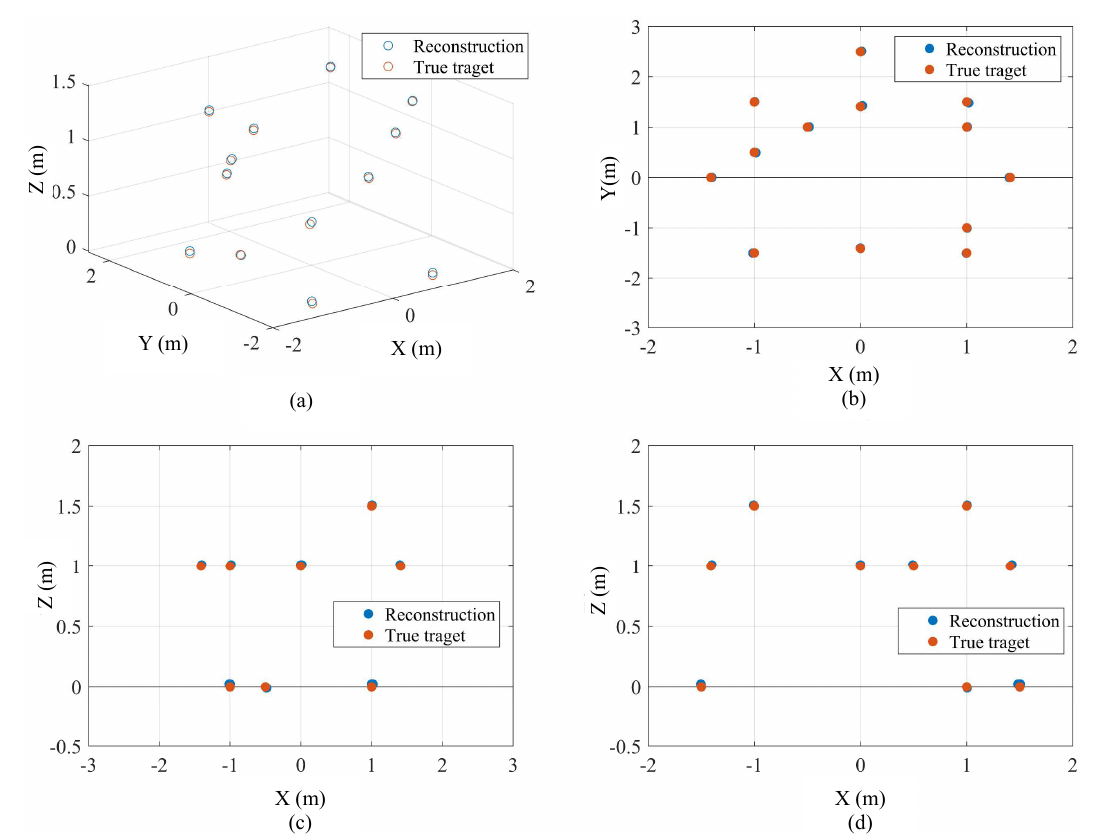
Figure 15. Three-dimensional image obtained by GRT with SNR = 20 dB. ( a ) Three-dimensional distribution of the reconstructed scatterers. ( b ) Projection of ( a ) onto the xy plane. ( c ) Projection of ( a ) onto the yz plane. ( d ) Projection of ( a ) onto the xz